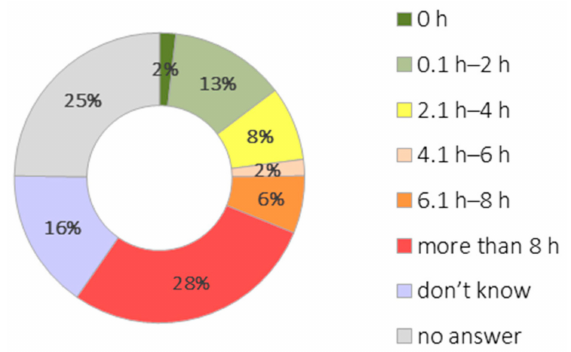
Figure 3. Hours that machines are in stand-by mode per